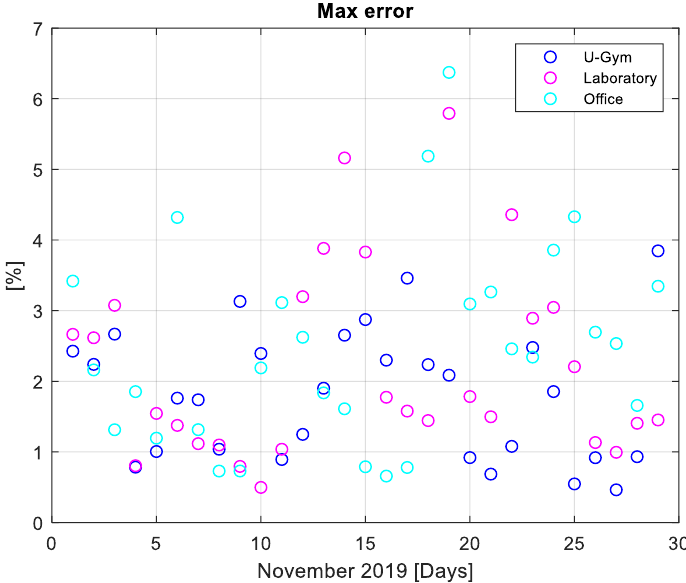
Figure 9. Nighttime temperature maximum percentage error.